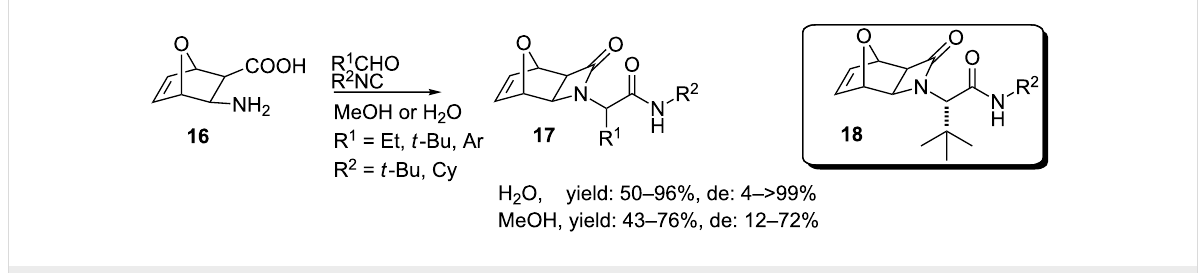
Scheme 7: The Ugi 4C-3CR towards oxabicyclo β -lactams.